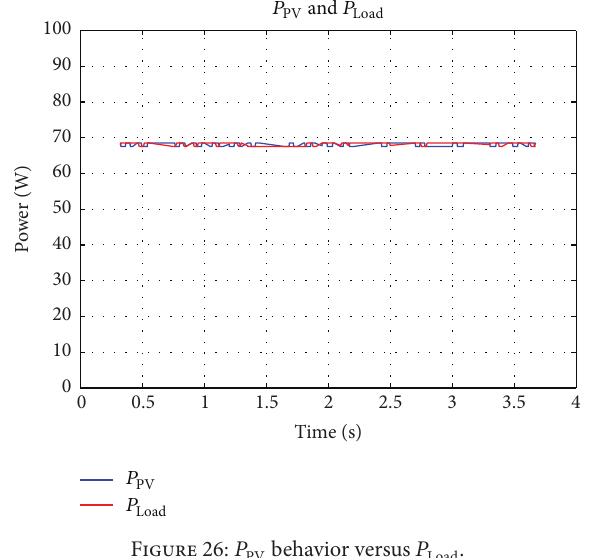
Figure 26: 𝑃 PV behavior versus 𝑃 Load .